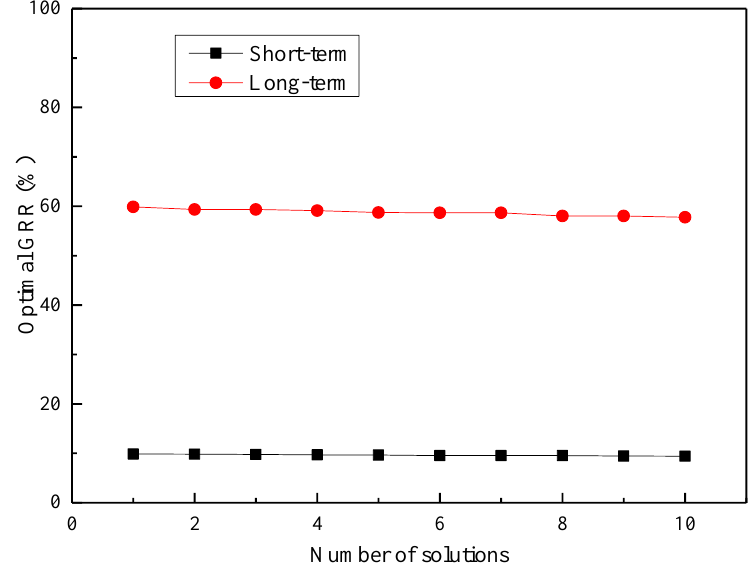
Figure 15. Optimal GRR for top 10 solutions.